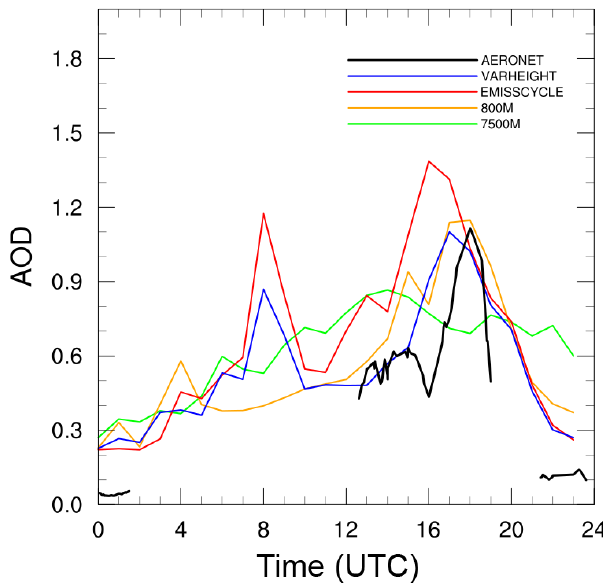
Figure 10. Comparison of measured (AERONET) and simulated AOD at Bratts Lake for 15 July